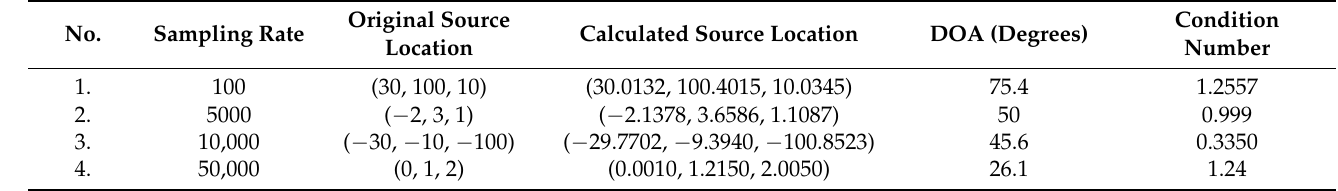
Table 1. Experimental results.